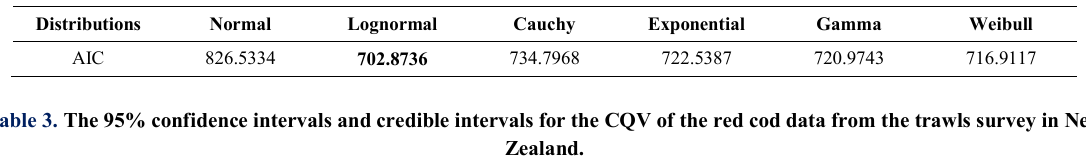
Figure 5. Distribution of log-transformed red cod data (a) a histogram (b) a normal Q-Q plot. Table 2. AIC values for fitting the distributions.